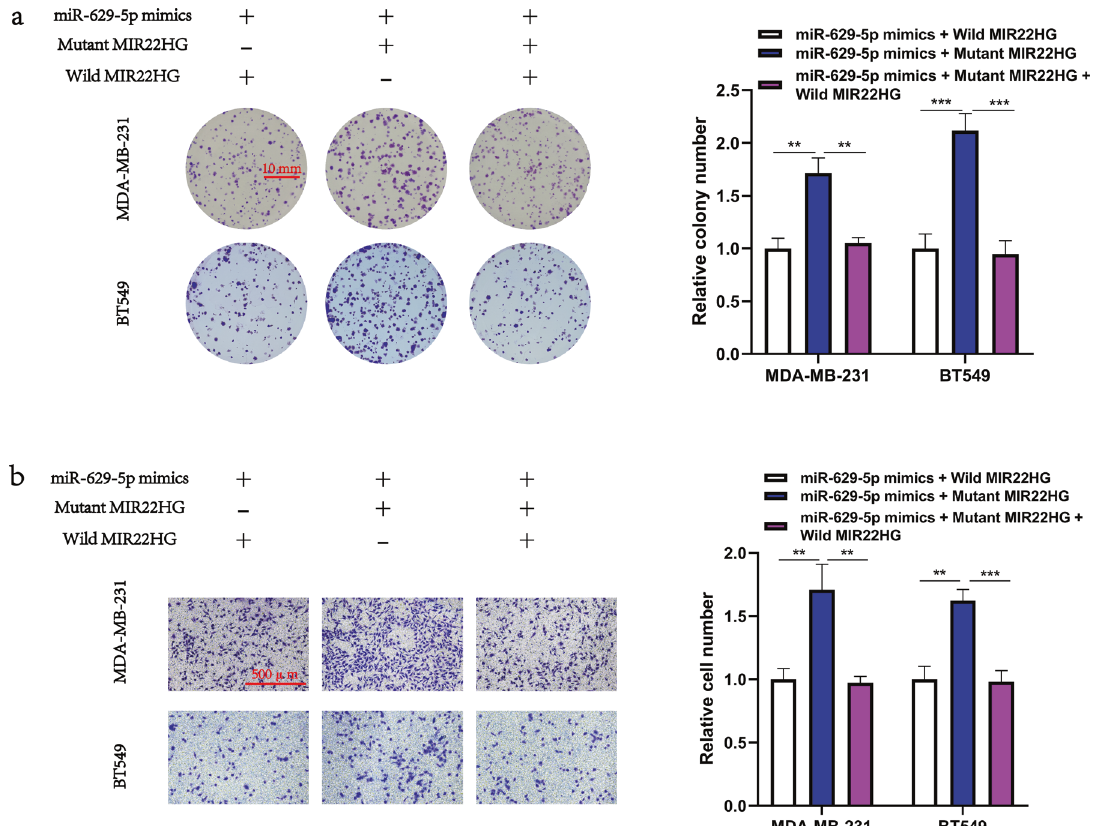
Fig. 5 Only wild-type MIR22HG functions as an miR-629-5p sponge in breast cancer cells. a Breast cancer cells co-transfected with miR- 629-5p and wild-type/mutant MIR22HG. Colony formation assay was used to assess the proliferation ability of MDA-MB-231 and BT549